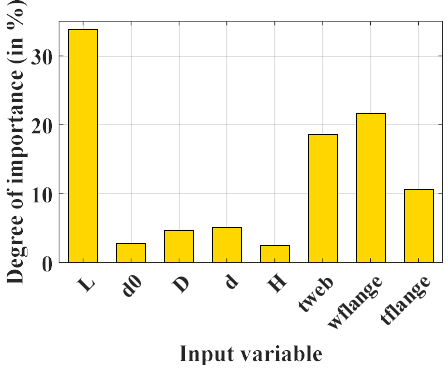
Figure 16. Bar graph showing the estimations of degree of importance values.